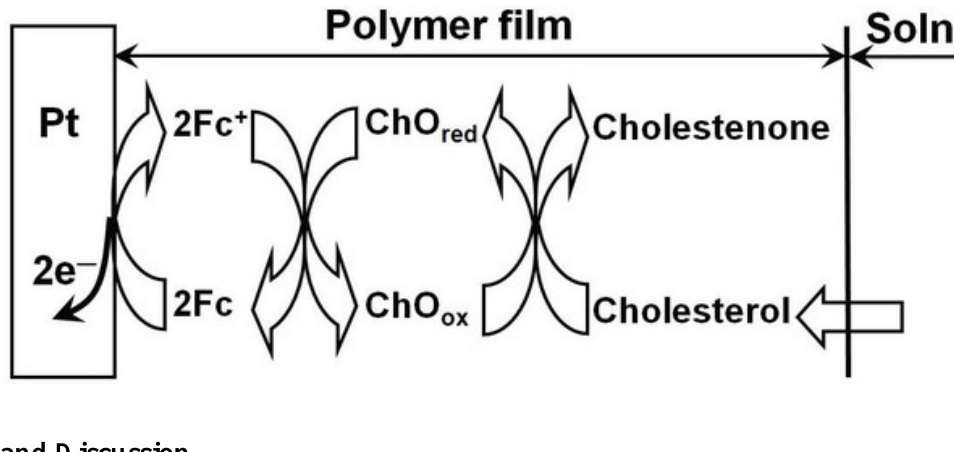
Figure 1. Schematic illustration of the sensing mechanism proposed for electrocatalytic oxidation of cholesterol on the modified electrode, where ferrocene acts as a